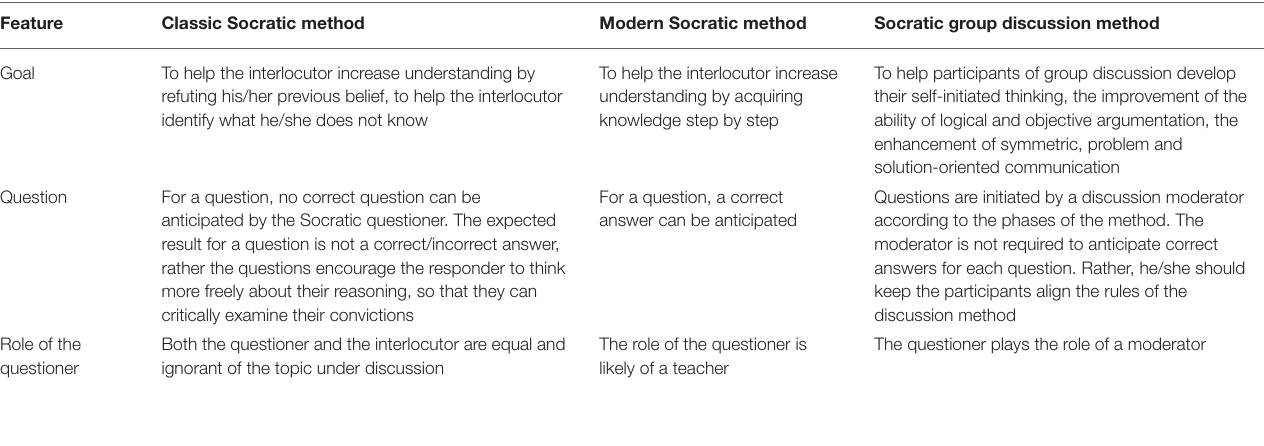
TABLE 2 | The differences between the Socratic